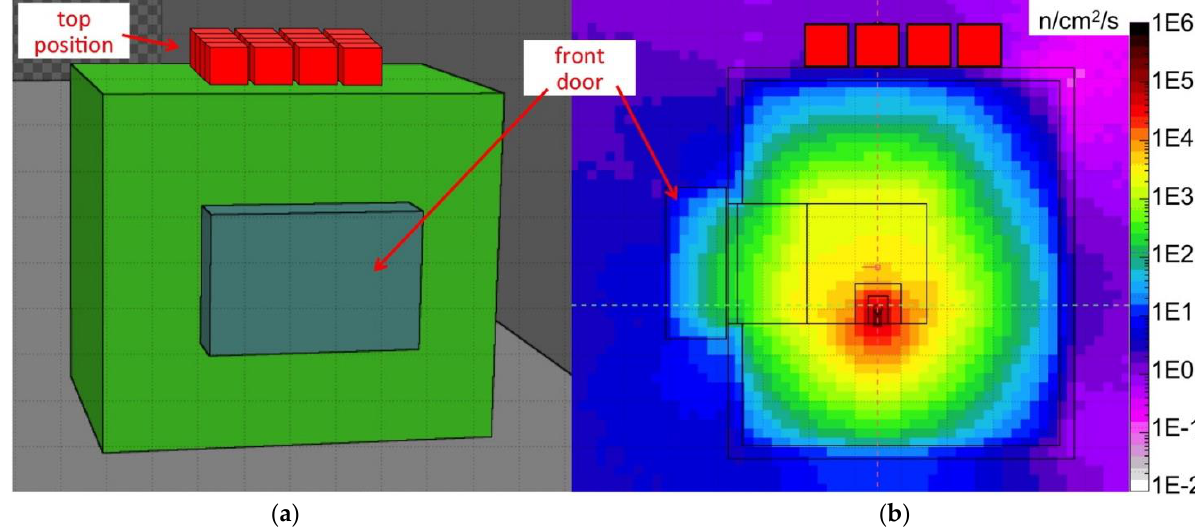
Figure 7. ( a ) Drawing of the top view of the section at 30 cm height of the neutron source box; the source position is in- dicated by a small dark circle, the red squares indicate the front and inside positions where the measurements were done; ( b ) the corresponding neutron flux obtained by means of a simulation with the Fluka code.